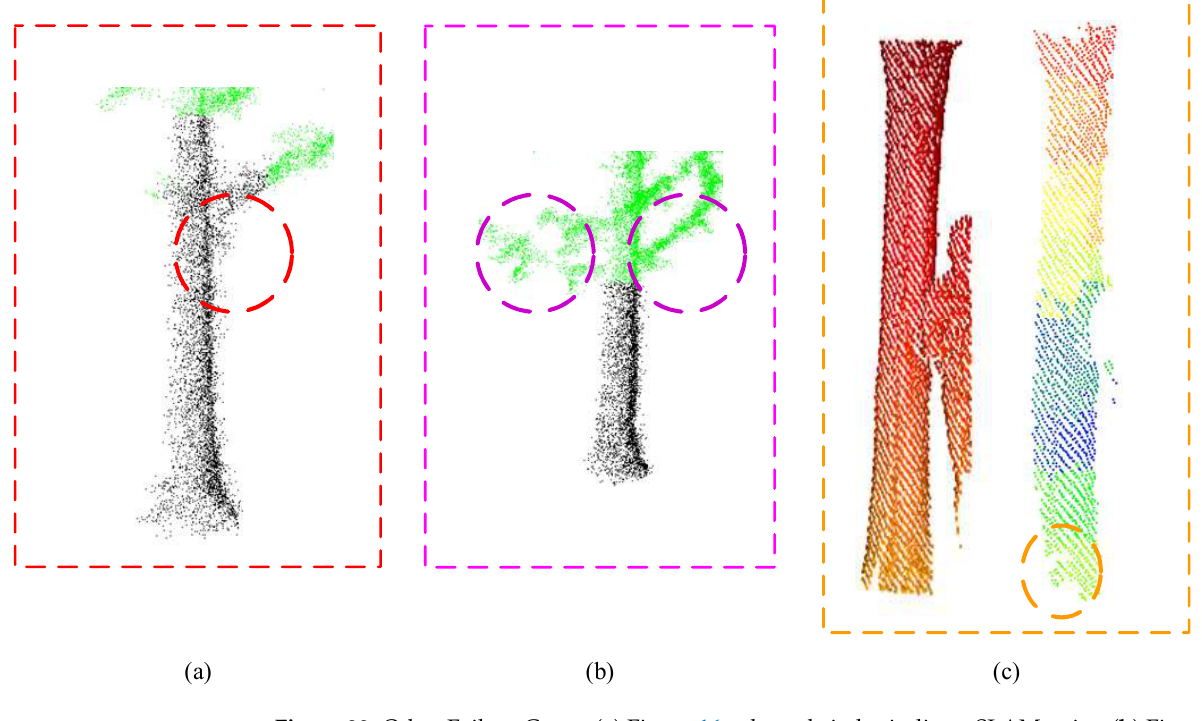
Figure 20. Other Failure Cases: ( a ) Figure 16c, the red circles indicate SLAM noise; ( b ) Figure 16d, the purple circles indicate the small branches on the trunk of the tree; ( c ) The denoising effect of Figure 14d; the orange circle indicates the excessive denoising part.